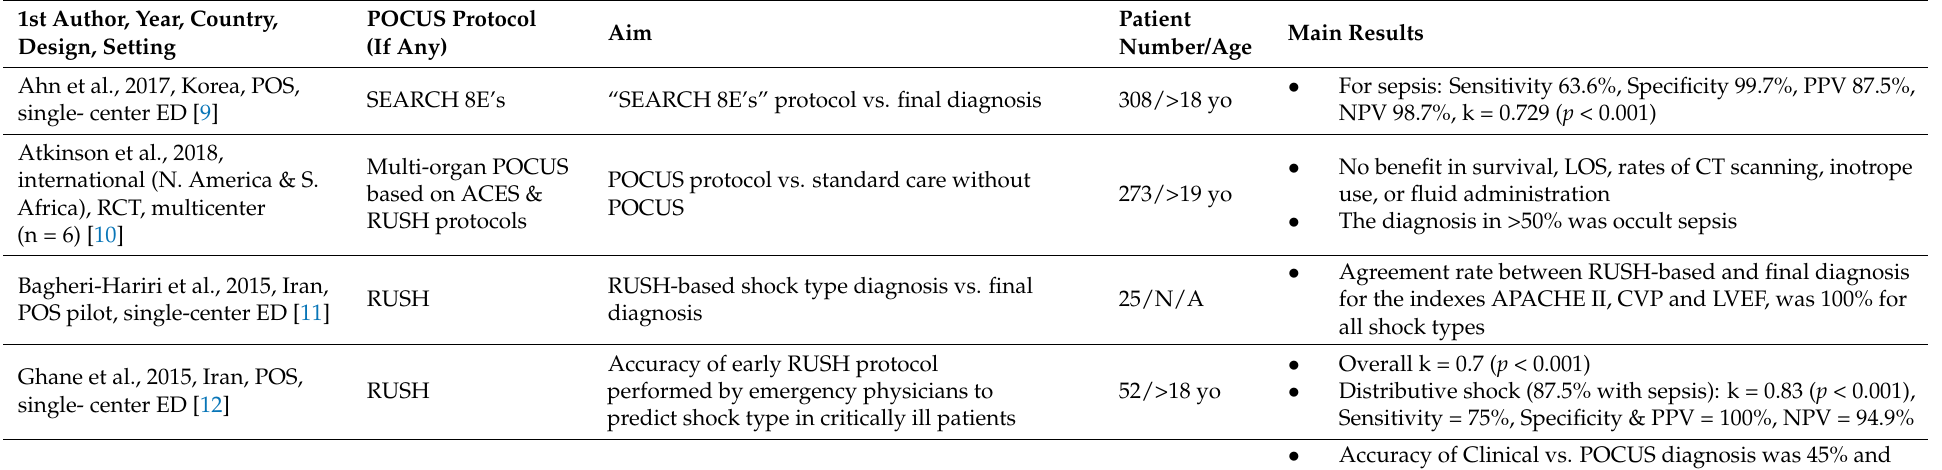
Table 1. Studies examining the contribution of POCUS to the diagnosis of undifferentiated hypotensive/critically ill patients